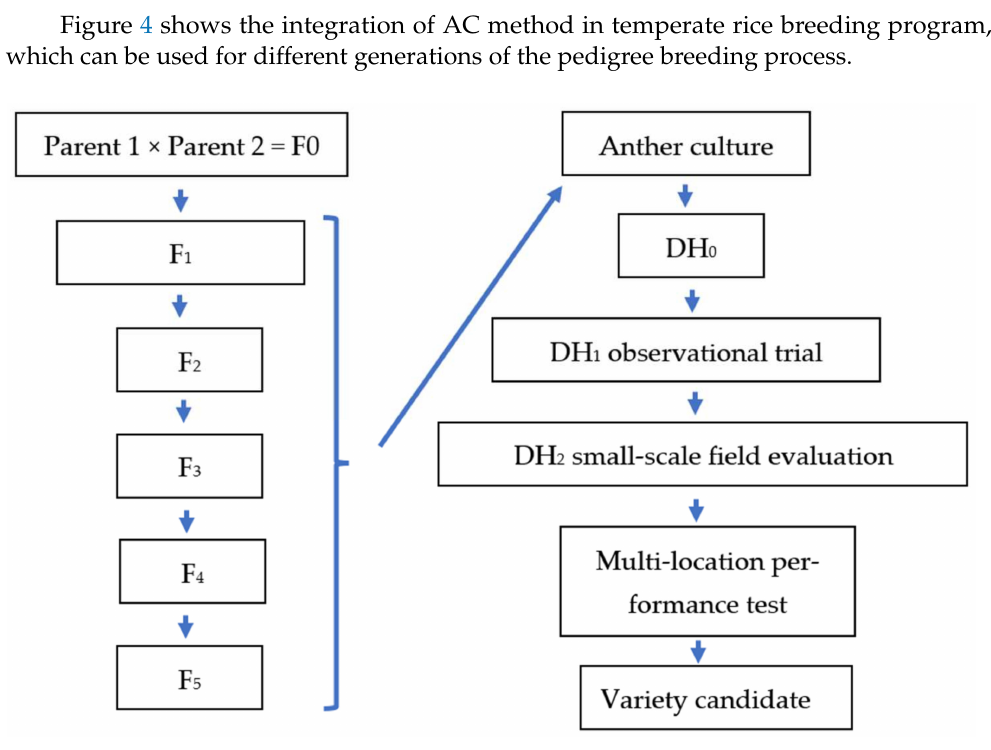
Figure 4. Integration of in vitro AC method into rice breeding program in